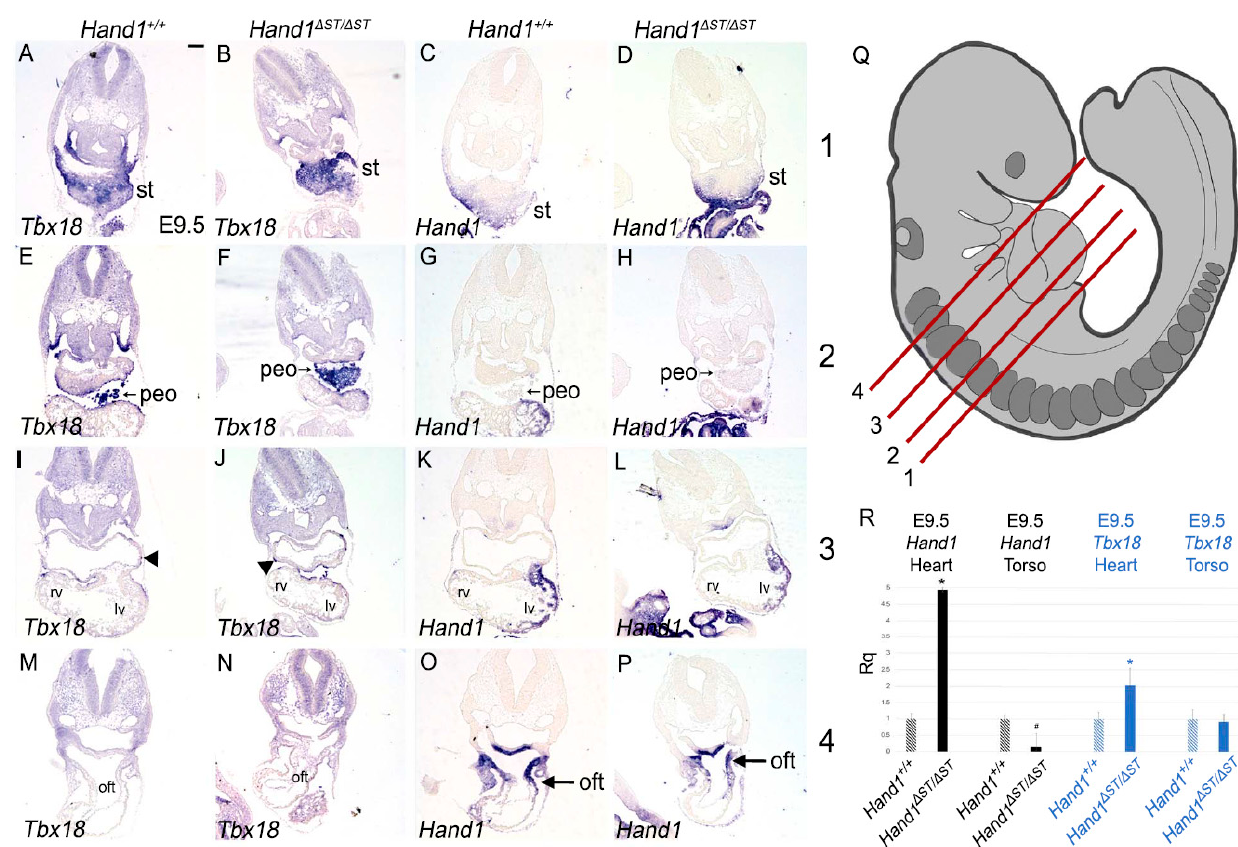
Figure 3. ST And PEO In Hand1 ∆ ST/ ∆ ST Embryo. ( A – P ) Section in-situ hybridization at E9.5 for Tbx18 and Hand1 mRNA in Hand1 +/+ and Hand1 ∆ ST/ ∆ ST embryos. Arrowheads indicate Tbx18 expressing cells migrating over the heart to form the epicardium. Arrows indicate Hand1 expression in the outflow tract. st, septum transversum; peo, proepicardial organ; rv, right ventricle; lv, left ventricle; oft, outflow tract. n =6 for all genotypes. Scale bar 100 µ m. ( Q ) Representation of E9.5 embryo showing planes of section indicated at rows: 1 (st), 2 (peo), 3 (four chamber heart), 4 (developing outflow tract). (R) qRT-PCR at E9.5 for Hand1 and Tbx18 expression in heart, and torso (dissected to exclude the heart, but with PEO and ST intact) in Hand1 +/+ and Hand1 ∆ ST/ ∆ ST embryos. n = 9 embryos, pooled. Significant increase in Hand1 (* indicates p ≤ 0.01, # indicates p ≤ 0.05) and Tbx18 (* indicates p ≤ 0.01) are observed. Error bars represent the high and low range of replicate cycle reads within each primer set.